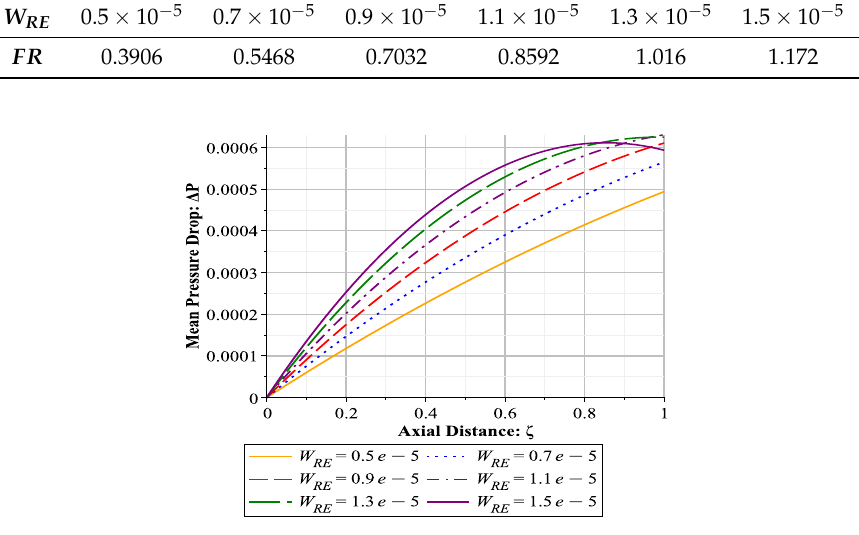
Figure 6. Behavior of ∆ P with ζ for different values of W RE .